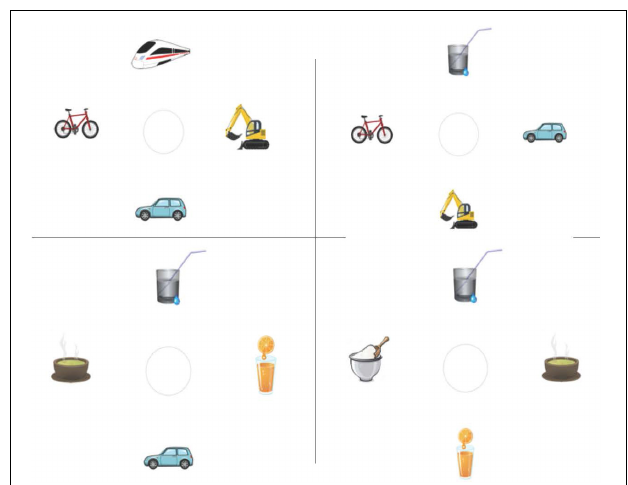
FIGURE 6 | Example stimuli for Experiment 4. From left to right and top to bottom: zero, one, three and four possible targets, given the sentence “The man spills soon the